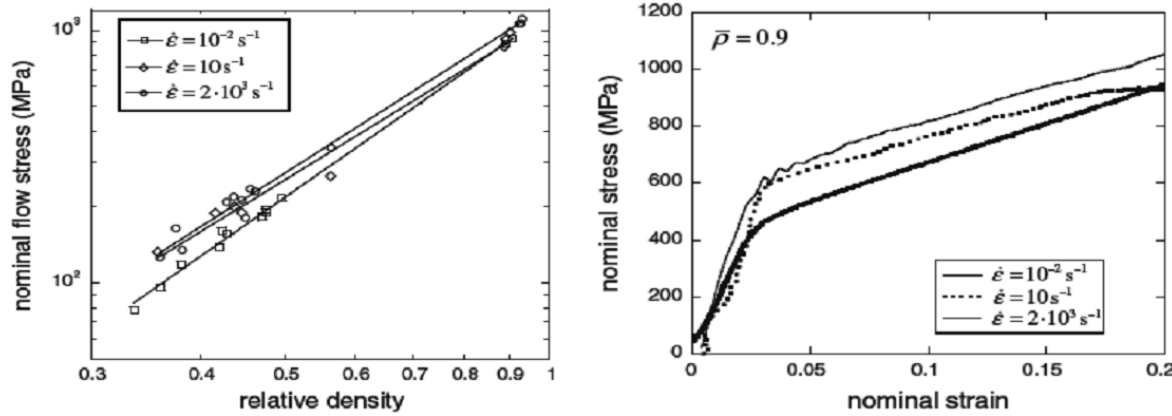
Figure 3. ( Left ) Measured flow stress (at a plastic strain of 0.2) as a function of foam density and strain rate; ( Right ) Stress versus strain response of sintered powder of relative density 0.9  at low, medium and high strain